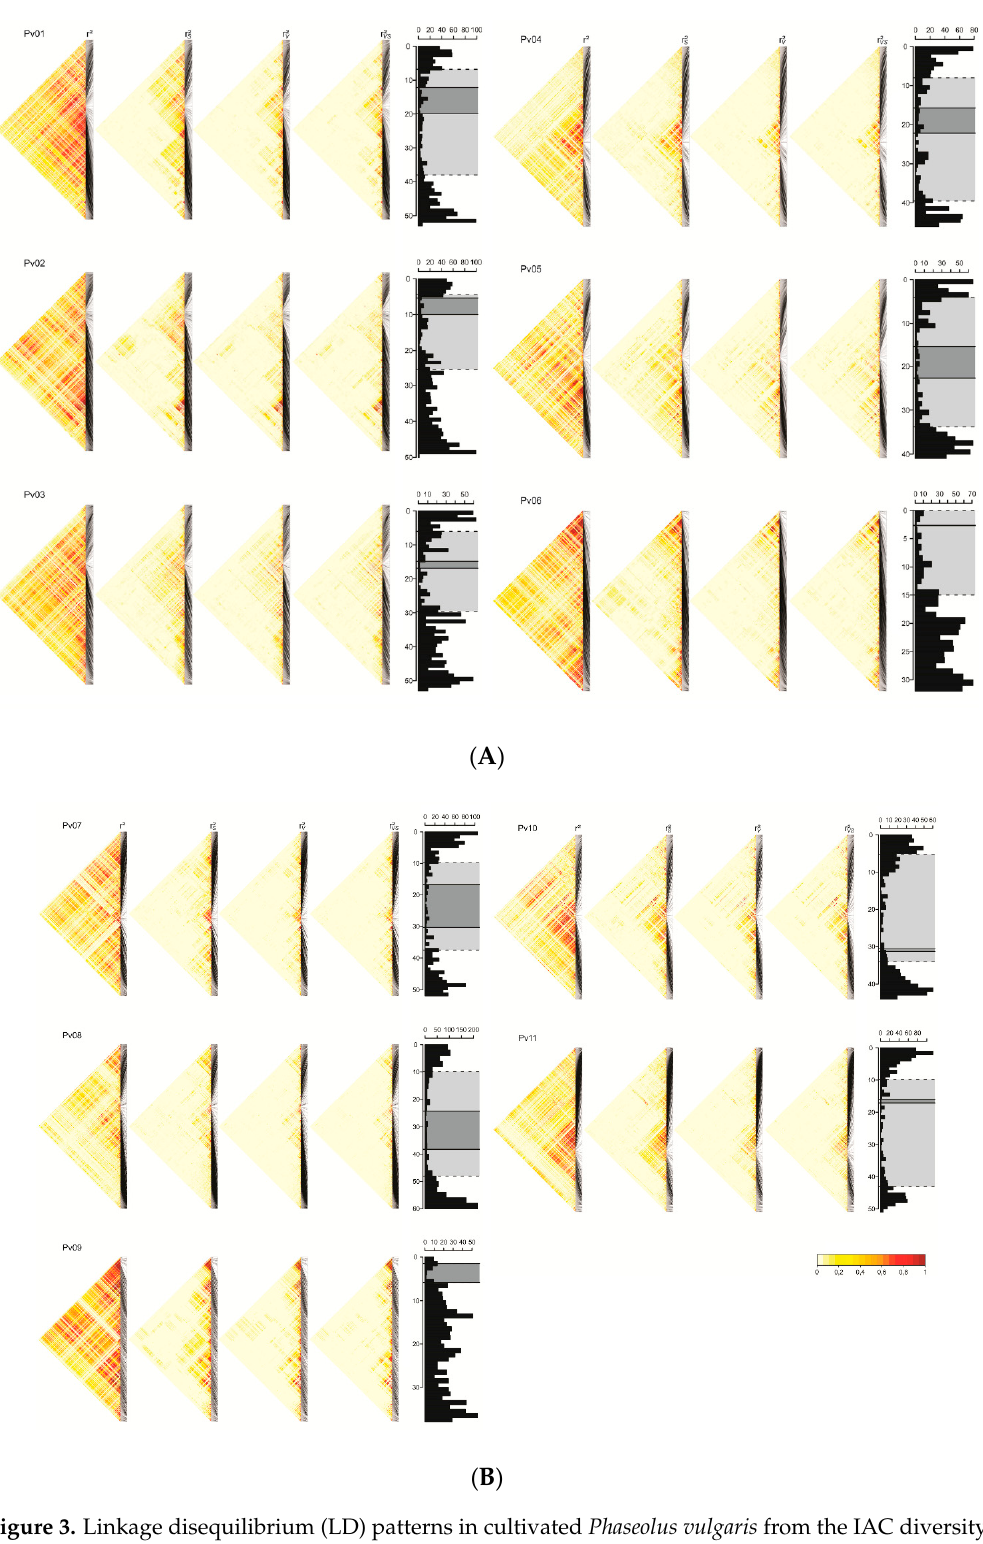
Figure 3. Linkage disequilibrium (LD) patterns in cultivated Phaseolus vulgaris from the IAC diversity panel. Histograms indicate SNP density along the chromosome: ( A ) chromosomes Pv01 to Pv06; ( B ) chromosomes Pv07 to Pv09. Ordinate and abscissa correspond to the loci position (Mb) and number of SNPs, respectively. The areas delimited by continuous and dashed lines correspond to centromeric and pericentromeric regions, respectively. LD heatmaps are shown for r 2 measurements and extensions correcting bias from population structure ( r 2 ), kinship ( r 2 ), and both combined ( r 2 ). The degree of V S VS LD is indicated by colors from light yellow (no LD) to red (strong